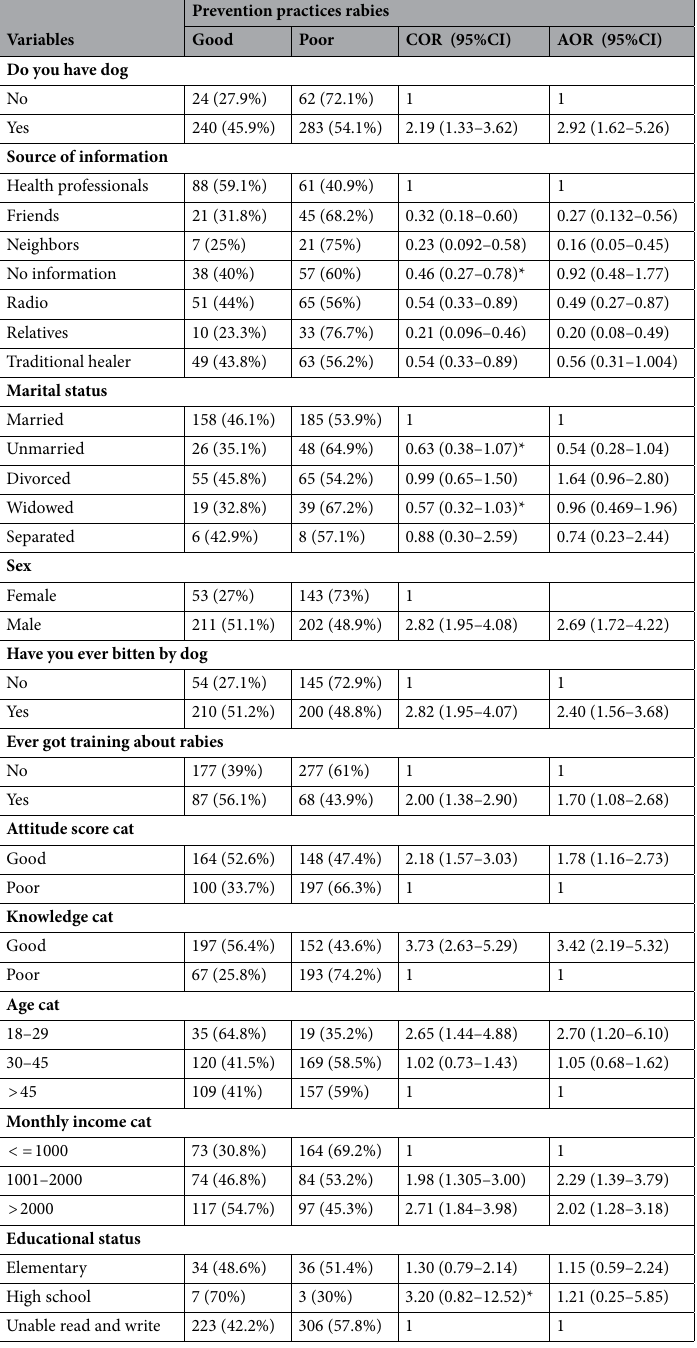
Table 4. Factors associated with good rabies prevention practices among household head in Bure Zuria district, Amhara, Ethiopia, Jun 01–30/2020. *‘P-value < = 0.2’ in the bivariate